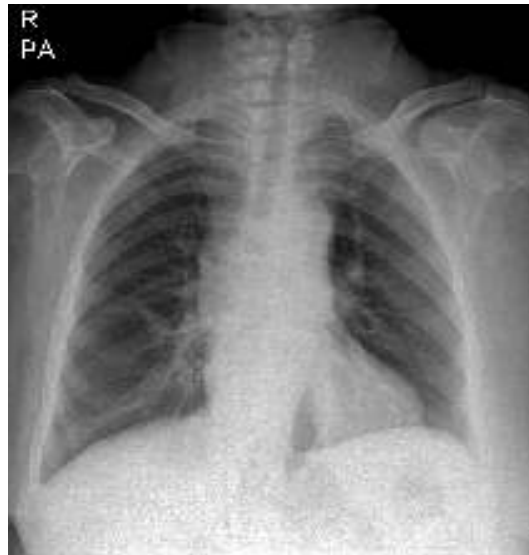
Figure 3. Chest X-ray after removal of catheter;